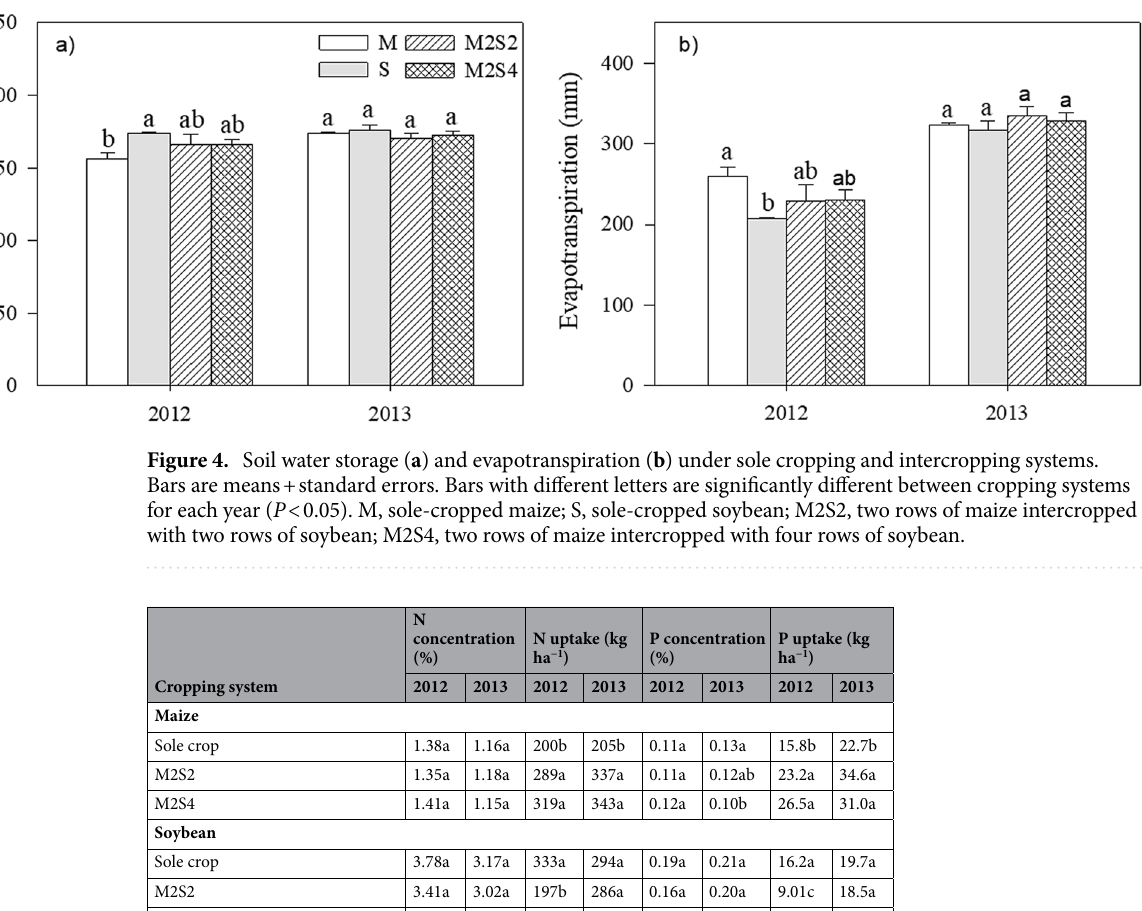
Cropping system